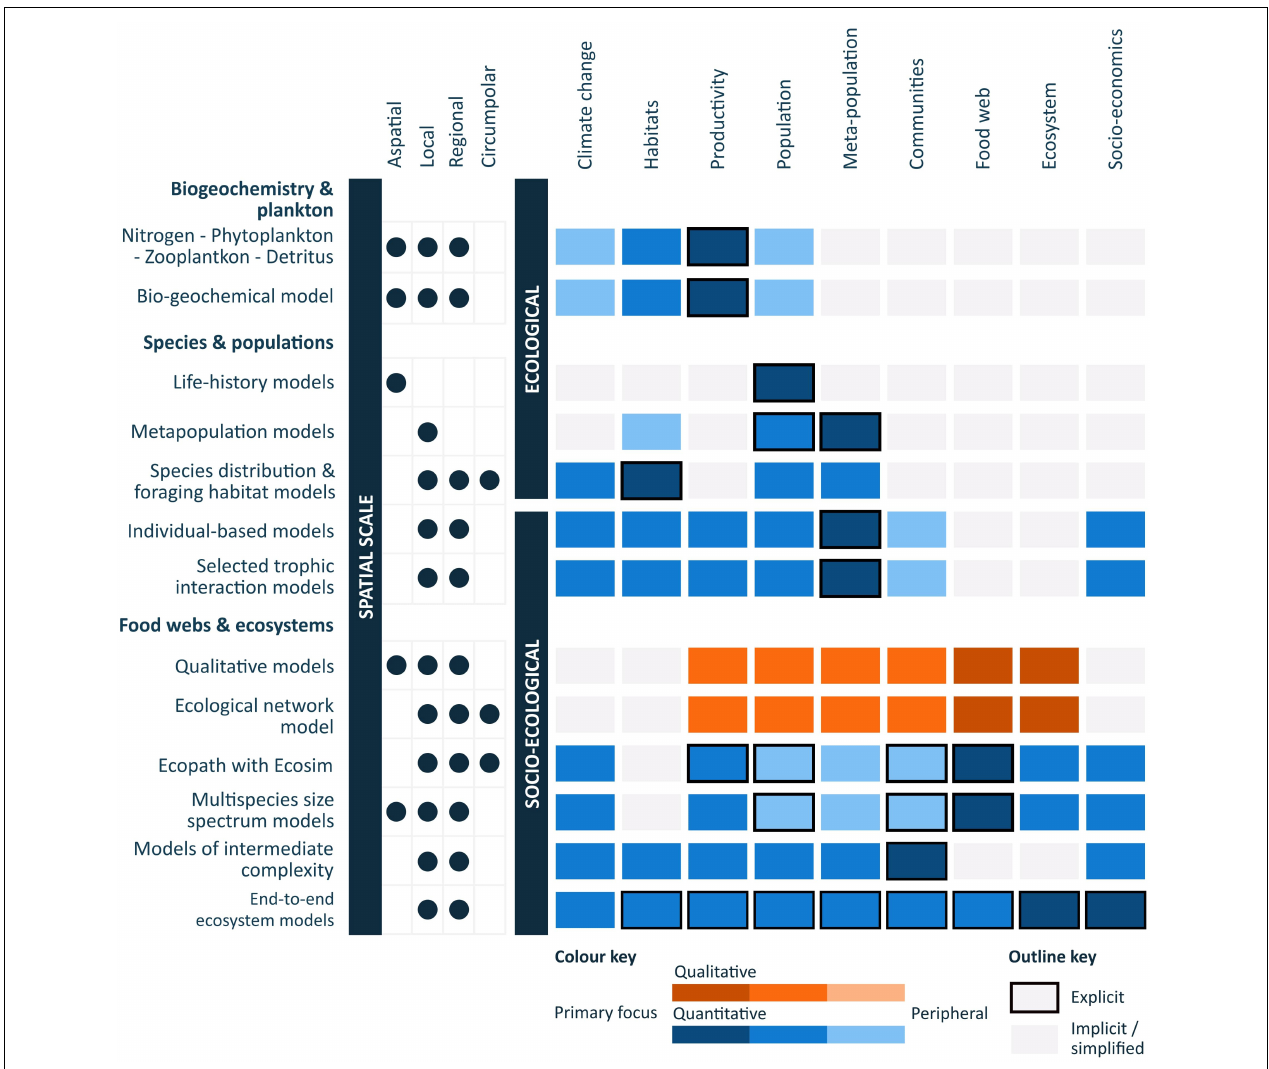
FIGURE 3 | Summary of various ecological modelling approaches and the associated spatial and socio-ecological scales at which they can be applied (concept visualisation based on Fulton and Link, 2014; Melbourne-Thomas et al., 2017). Coloured rectangles indicate the inclusion and level of focus (i.e., dark—primary focus, light—peripheral) of each of the components for the summarised qualitative (orange) and quantitative (blue) models. Reference to spatial scales relate to Southern Ocean